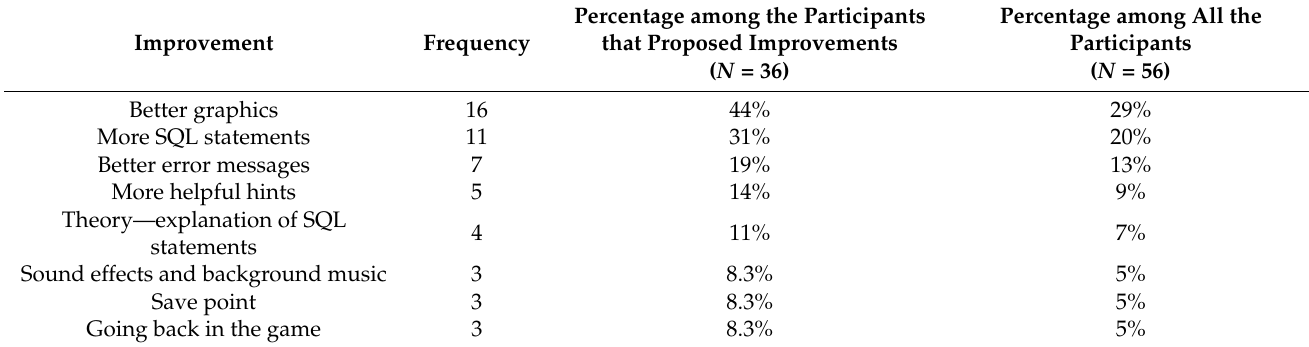
Table 7. Proposed improvements for SQL